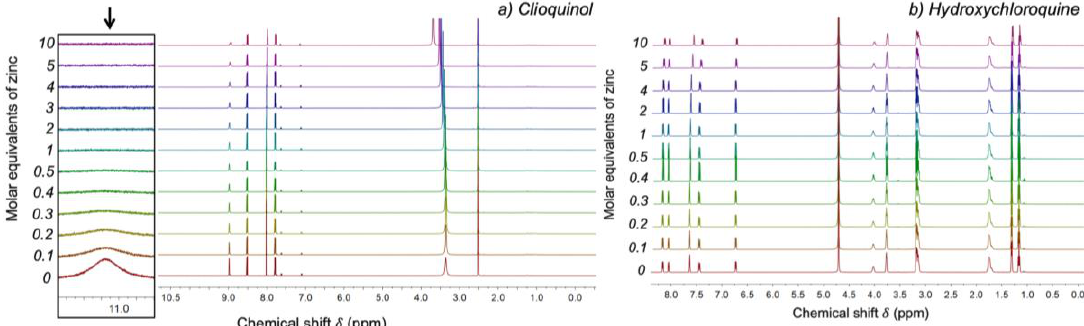
Figure 2. 1 H-NMR complexation studies of ( a ) CQ (in DMSO-d6) and ( b ) HCQ (in D 2 O) solutions titrated with ZnCl 2 (in D 2 O).